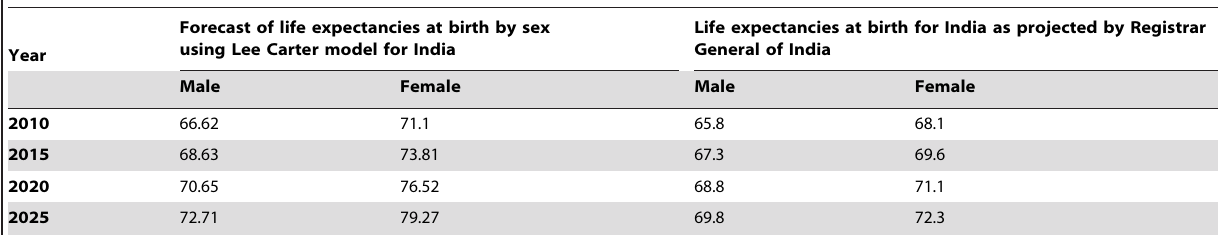
Table 7. Comparative forecasted life expectancy at birth between Lee-Carter model and Registrar General of India by sex, India.